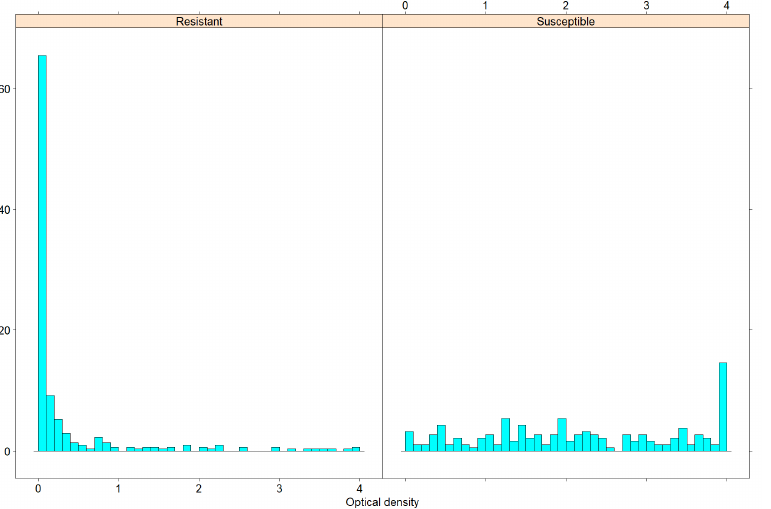
Figure 2. Histograms of optical density (OD) values for the two pools of resistant ( left ) and suscepti- ble ( right ) genotypes. The X axis represents OD values in the range from 0 to 4 with a binning width of 0.1. The Y axis represents percentage of measurements in each